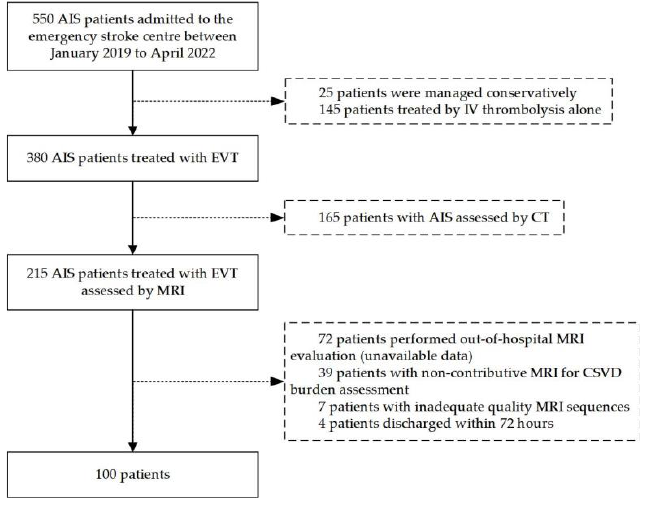
Figure 1. Flow chart of the study. AIS: acute ischemic stroke; EVT: endovascular therapy; IV: intravenous; CSVD: cerebral small vessel disease. Compared with those ( n = 380) excluded from current analyses, the baseline charac- teristics of the patients were similar between the included and excluded patients (Table 1). There were no differences between the included and excluded patients in terms of clin- ical severity or medical history. Table 1. Baseline characteristics of the included versus excluded patients. Total ( n = 380)